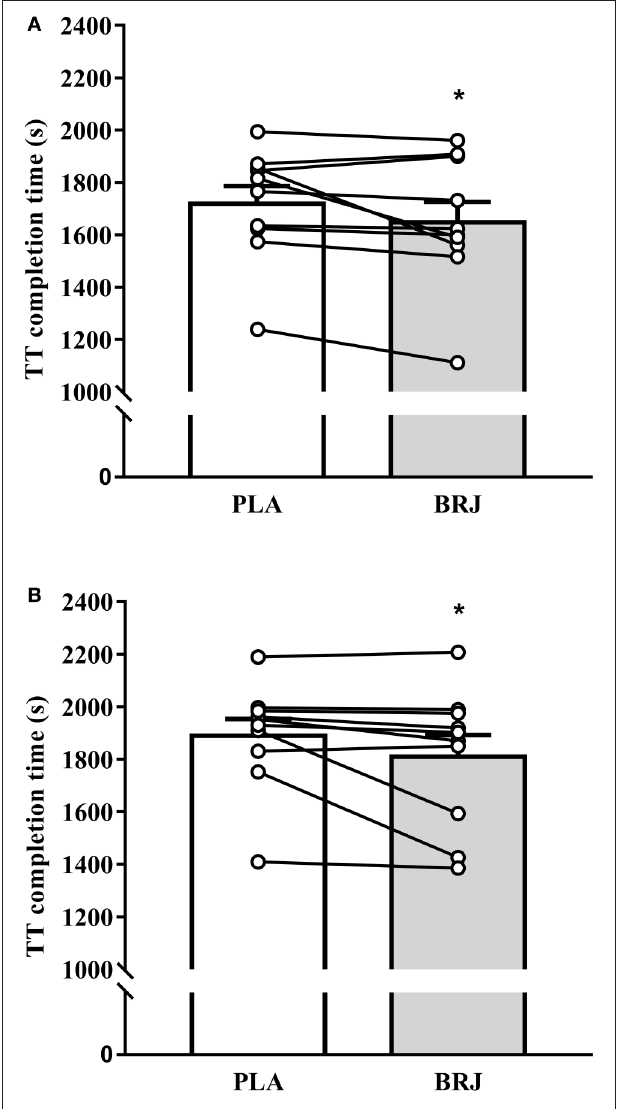
FIGURE 5 | Performance in the 3 km time-trial (TT) at 3,000m (A) and 4,300m (B) simulated altitude following nitrate-rich beetroot juice (BRJ) and nitrate-deplete placebo (PLA) supplementation. The closed bars depicts the mean and SEM performance times from the BRJ trials at each altitude, and the open bar represents the mean and SEM performance times from the PLA trials at each altitude. Lines represent the individual participant changes in performance times with BRJ supplementation. *Significant main effect of supplement ( p <